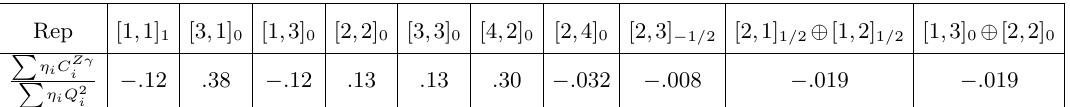
The contribution of viable Loryons to κ To maintain κ within 20 percent of the SM value while flipping the sign of κ Zγ | P η i C Zγ / P η i Q 2 | < . 074 i i